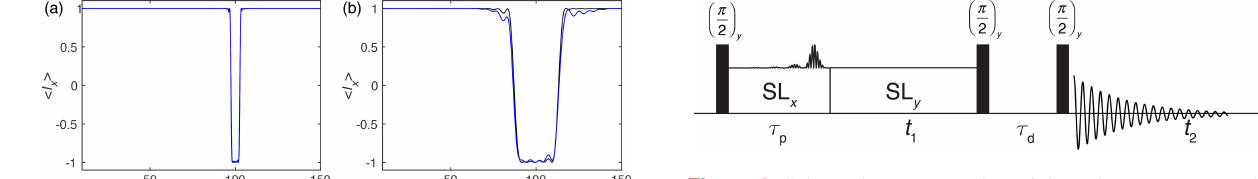
Figure 3. Schematic representation of the pulse sequence used for testing of the inversion properties of the I-BURP-2 pulse in the spin-lock frame. After the initial 90 ◦ pulse, the magnetization is spin locked along x and the modulated I-BURP-2 inversion pulse applied along y . During the subsequent t 1 time the magnetization nutates about the field along y . To obtain pure-phase spectra, a z filter with a dephasing delay is used to select a single component after the nutation. Difference spectra can be obtained by replacing the I-BURP-2 pulse in the spin-lock frame with a simple spin lock in alternating scans while shifting the receiver phase by 180 ◦